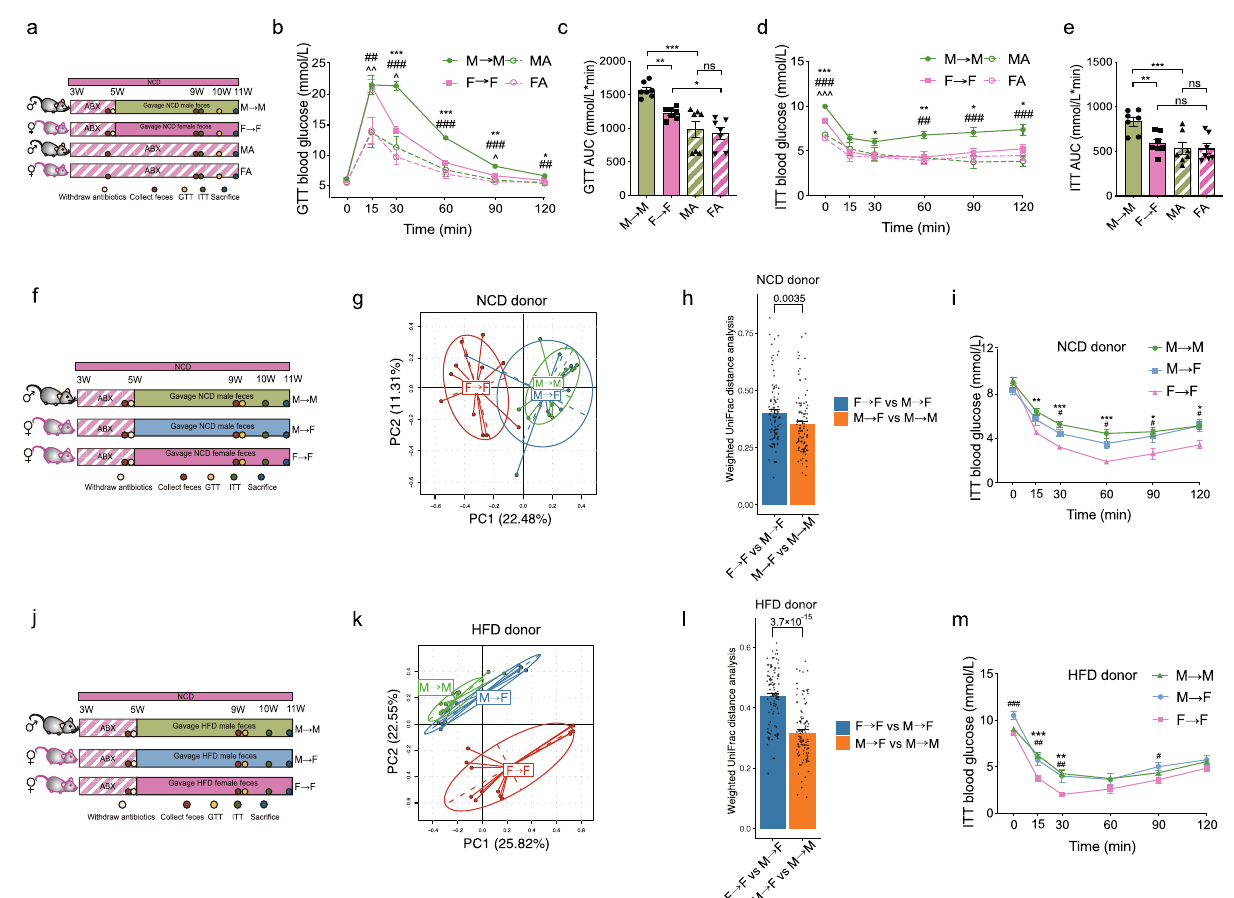
Fig. 3 Sex-speci fi c gut microbiome drives sexual dimorphism in insulin sensitivity. a Schematic diagram of the gut microbiome reconstruction in male and female recipient mice receiving feces from NCD-fed male and female donor mice respectively (mice, n = 7 per group). b , c GTT ( b ) (for M → M VS MA, P = 0.006 and for F → F VS FA, P = 0.009 at 15 min; for M → M VS F → F, P = 3.8 × 10 − 4 , for M → M VS MA, P = 5.9 × 10 − 6 , and F → F VS FA, P = 0.017 at 30 min; for M → M VS F → F, P = 1.4 × 10 − 4 and for M → M VS MA, P = 5.1 × 10 − 6 at 60 min; for M → M VS F → F, P = 0.002, for M → M VS MA, P = 7.1 × 10 − 5 , and for F → F VS FA, P = 0.038 at 90 min; for M → M VS F → F, P = 0.041 and for M → M VS MA, P = 0.002 at 120 min) and the corresponding AUC ( c ) (for M → M VS F → F, P = 0.005, for M → M VS MA, P = 2.0 × 10 − 5 , and for F → F VS FA, P = 0.012) in the indicated groups (mice, n = 7 per group). d , e ITT (d) (for M → M VS F → F, P = 1.5 × 10 − 6 , for M → M VS MA, P = 1.1 × 10 − 11 , and for F → F VS FA, P = 1.3 × 10 − 7 at 0 min; for M → M VS F → F, P = 0.041 at 30 min; for M → M VS F → F, P = 0.004 and for M → M VS MA, P = 0.003 at 60 min; for M → M VS F → F, P = 0.013 and for M → M VS MA, P = 5.6 × 10 − 4 at 90 min; for M → M VS F → F, P = 0.012 and for M → M VS MA, P = 1.6 × 10 − 4 at 120 min) and the corresponding AUC ( e ) (for M → M VS F → F, P = 0.004 and for M → M VS MA, P = 7.0 × 10 − 4 ) in the indicated groups (mice, n = 7 per group). f Schematic diagram of FMT in female recipient mice receiving feces from NCD-fed male and female donor mice respectively. g PCA of the gut microbiome based on the OTUs of the indicated groups (mice, n = 11 for M → M and F → F; n = 9 for M → F). The donors were fed the NCD. h Weighted UniFrac distance analysis of the gut microbiome in the indicated groups (mice, n = 11 for M → M and F → F; n = 9 for M → F). The donors were fed a NCD. i ITT in M → M, M → F, and F → F groups (for M → M VS F → F, P = 0.004 at 15 min; for M → M VS F → F, P = 3.1 × 10 − 4 and for M → F VS F → F, P = 0.019 at 30 min; for M → M VS F → F, P = 6.7 × 10 − 4 and for M → F VS F → F, P = 0.020 at 60 min; for M → M VS F → F, P = 0.015 and for M → F VS F → F, P = 0.045 at 90 min; for M → M VS F → F, P = 0.033 and for M → F VS F → F, P = 0.032 at 120 min) (mice, n = 11 for M → M; n = 7 for F → F; n = 11 for M → F). The donors were fed a NCD. j Schematic diagram of FMT in female recipient mice receiving feces from HFD-fed male and female donor mice respectively. k PCA of the gut microbiome based on the OTUs of the indicated groups (mice, n = 13 for M → M and F → F; n = 8 for M → F). The donors were fed a HFD. l Weighted UniFrac distance analysis of the gut microbiome in the indicated groups (mice, n = 13 for M → M and F → F; n = 8 for M → F). The donors were fed a HFD. m ITT in M → F, M → F, and F → F groups (for M → F VS F → F, P = 3.8 × 10 − 4 at 0 min; for M → M VS F → F, P = 1.7 × 10 − 4 and for M → F VS F → F, P = 0.002 at 15 min; for M → M VS F → F, P = 0.002 and for M → F VS F → F, P = 0.006 at 30 min; for M → F VS F → F, P = 0.012 at 90 min) (mice, n = 13 for M → M; n = 12 for F → F and M → F). The donors were fed a HFD. ABX, antibiotics; GTT, glucose tolerance test; AUC, area under the curve; ITT, Insulin tolerance test; NCD, normal chow diet; HFD, high fat diet. M → M, male feces transferred to male recipients; F → F, female feces transferred to female recipients; MA, male mice with ABX treatment; FA, female mice with ABX treatment. M → F, male feces transferred to female recipients. For Fig. 3 b , d , M → M VS F → F, * P < 0.05, ** P < 0.01, *** P < 0.001; M → M VS MA, # P < 0.05, ## P < 0.01, ### P < 0.001; F → F VS FA, ^ P < 0.05, ^^ P < 0.01, ^^^ P < 0.001. For Fig. 3 i , m , M → M VS F → F, * P < 0.05, ** P < 0.01, *** P < 0.001; M → F VS F → F, # P < 0.05, ## P < 0.01, ### P < 0.001.